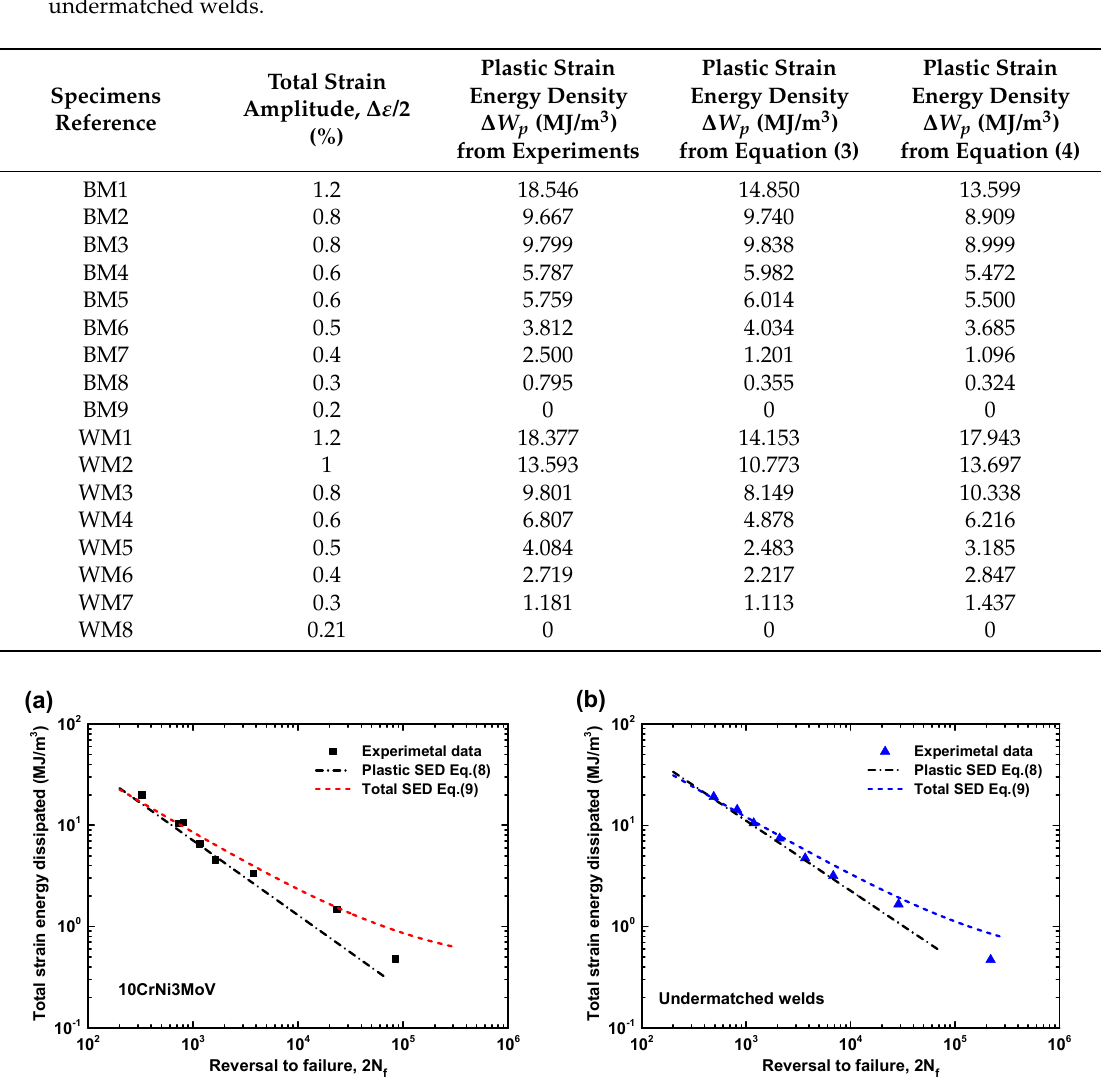
Table 7. Experimental and theoretical ∆ W p values of 10CrNi3MoV high strength steel and undermatched welds.